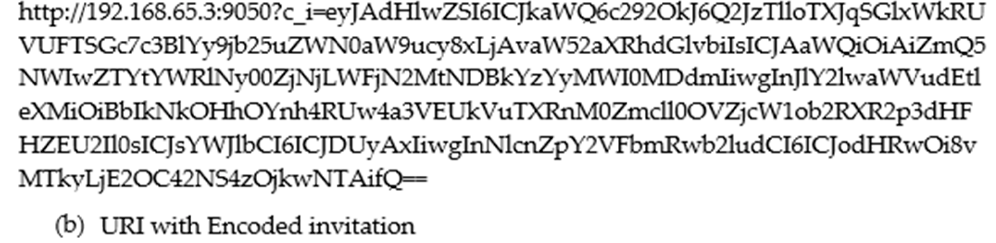
Figure 28. Charging request